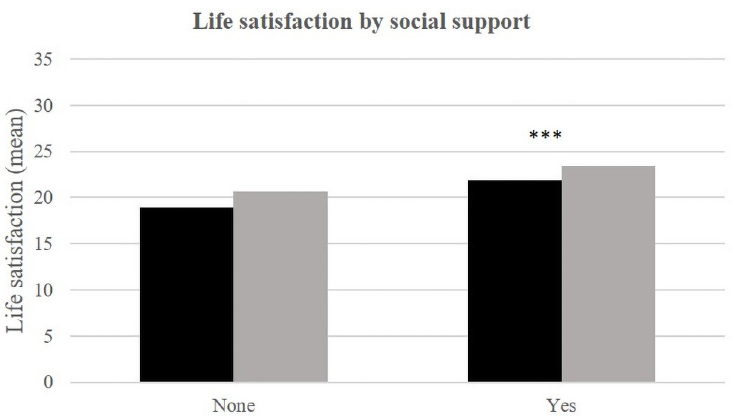
Fig 7. Life satisfaction (mean) by social support and place of life.